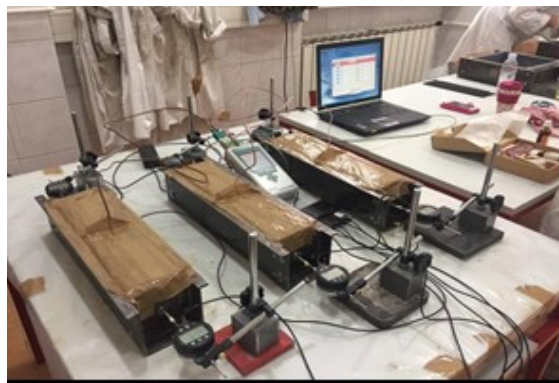
Figure 6. Testing autogenous deformations.